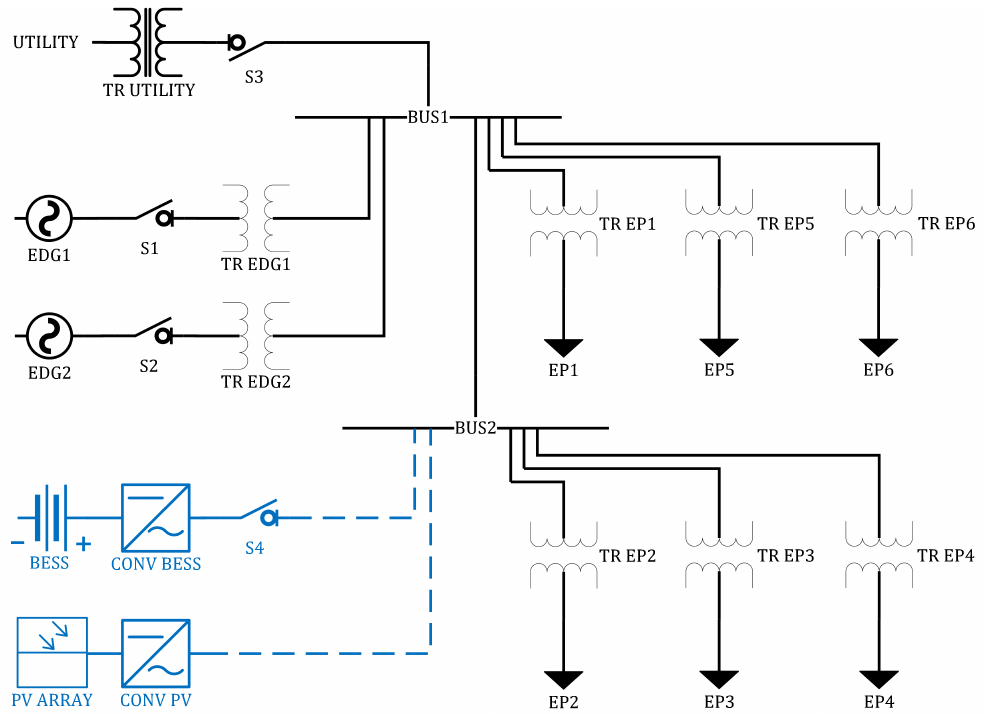
Figure 5. Microgrid one-line diagram for Naval Support Activity Monterey (NSA Monterey). The cur- rent configuration is comprised of two EDGs, six loads (EP1–6), and a utility connection at BUS1. Other possible generation sources (blue elements) include ESSs and PV arrays. Adapted from Peterson et al. [14].